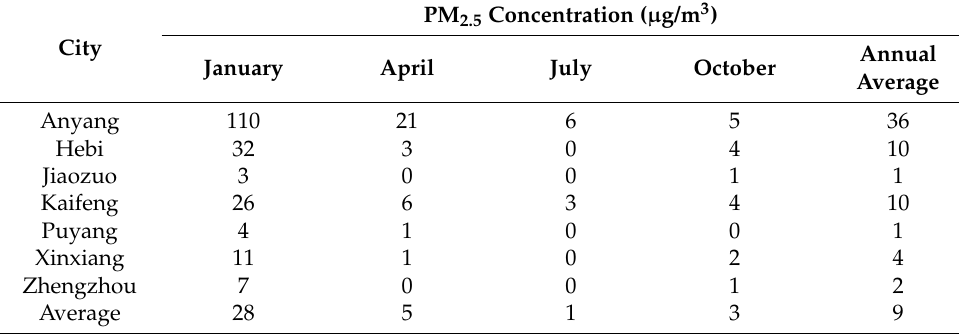
Table 7. Reduction potential of PM 2.5